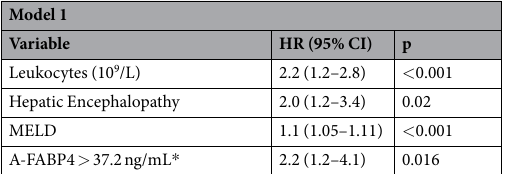
Table 5. Cox regression analysis of 90-day transplant-free survival. HR, hazard ratio; CI, confidence interval; AUROC 0.833. Variables included in the model: MELD, ascites, hepatic encephalopathy, leukocyte count, L-FABP1, A-FABP4, acute kidney injury, ACLF. * A-FABP4 was not introduced in the model as a continuous variable because it did not have a normal distribution and there was no linearity between hazard ratios of different quartiles. A categorical distribution with the median value was used